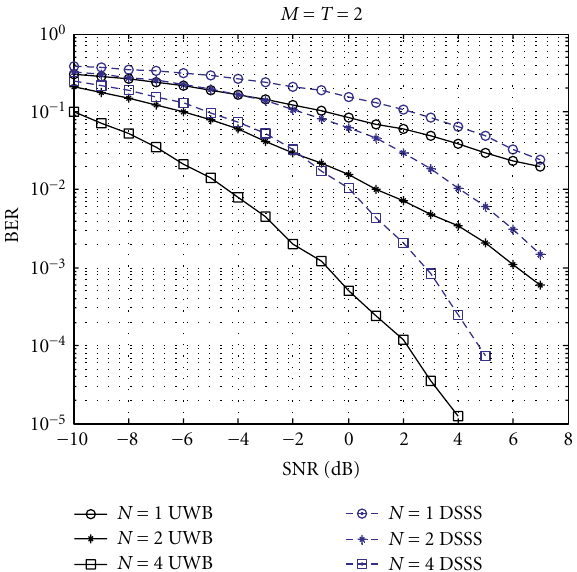
−0.7−0.6−0.5−0.4−0.3−0.2